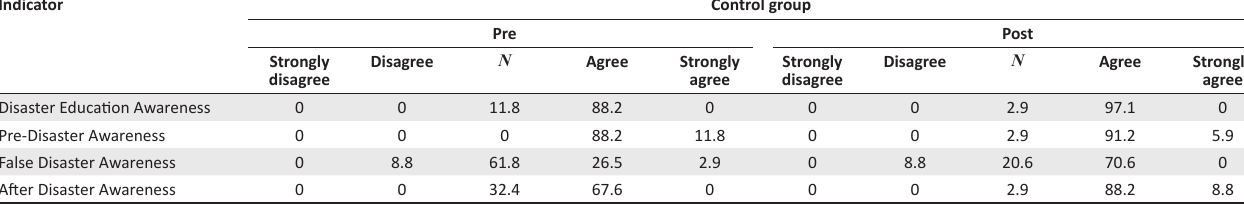
TABLE 7: Percentage of rural students’ responses from control groups. Indicator